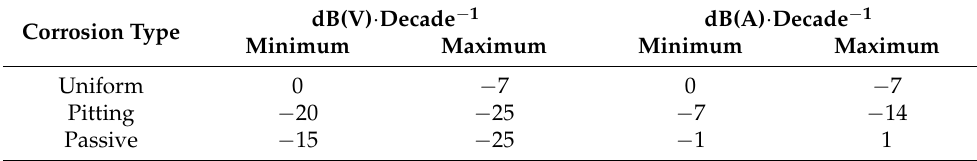
Table 4. β intervals to indicate the type of corrosion